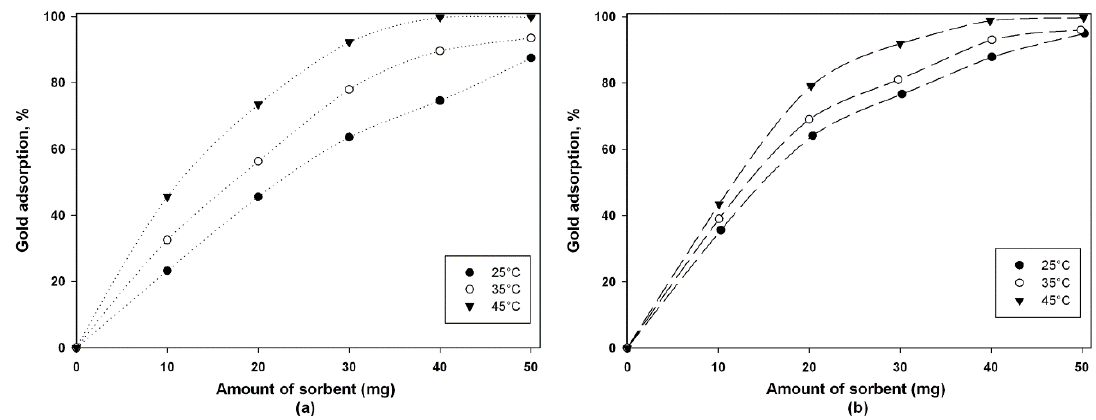
Figure 2. Gold adsorption capacity (mg/g) as a function of contact time by the (a) ARH and by (b) L-214 (25 °C, 100 rpm, pH = 6.1, and 10 mL sol.).